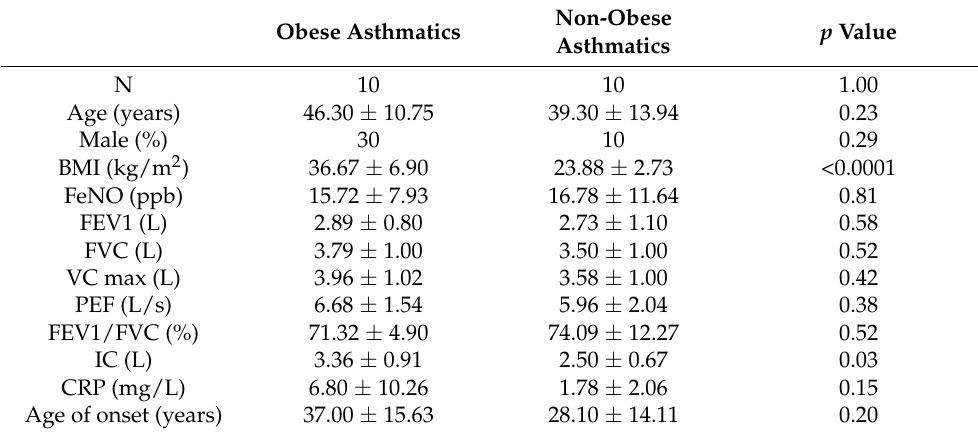
Table 1. General patient characteristics of the two low type-2 asthma patient groups. Obese Asthmatics